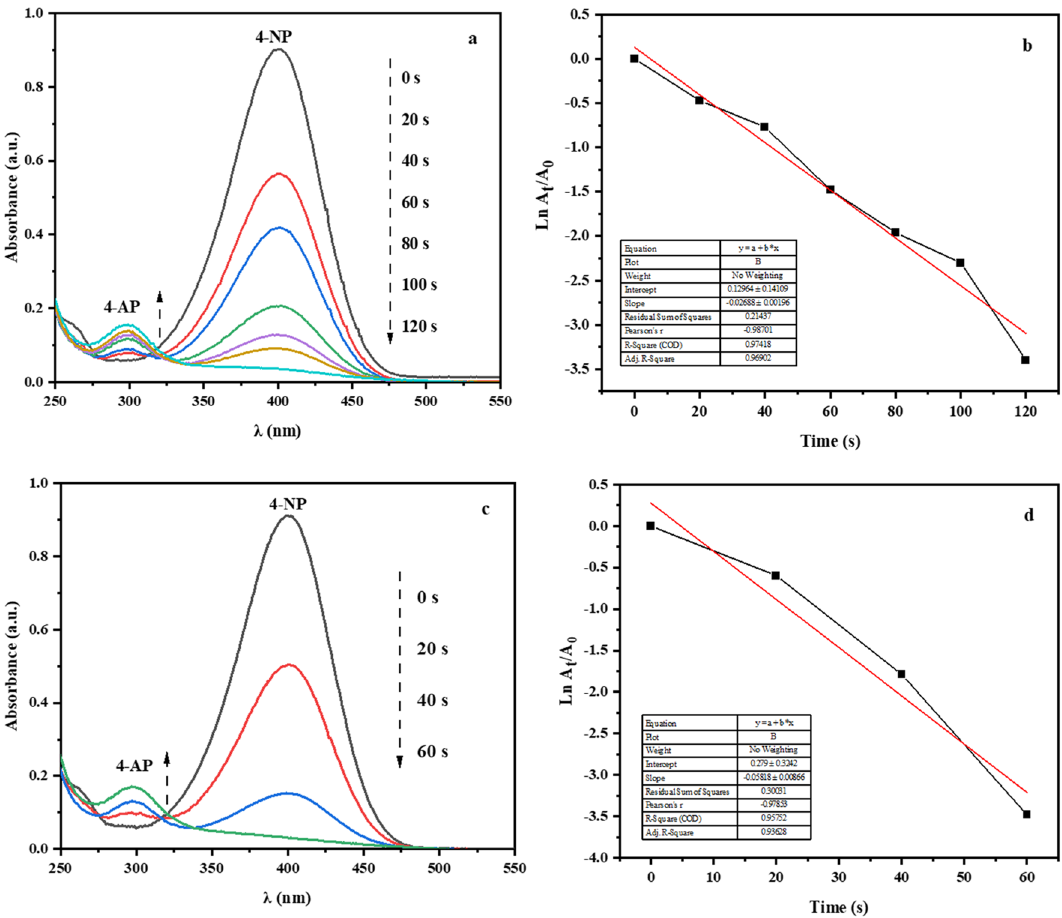
Figure 13. ( a ) Reduction of 4-NP in aqueous solution recorded every 20 s using Fe-Ben/PVP-DVB/Pd nanocatalyst (1 mg); ( b ) ln (A t /A 0 ) versus reaction time for reduction of 4-NP. ( c ) Reduction of 4-NP in aqueous solution recorded every 20 s using Fe-Ben/PVP-DVB/Pd nanocatalyst (2 mg); ( d ) ln (A t /A 0 ) versus reaction time for reduction of